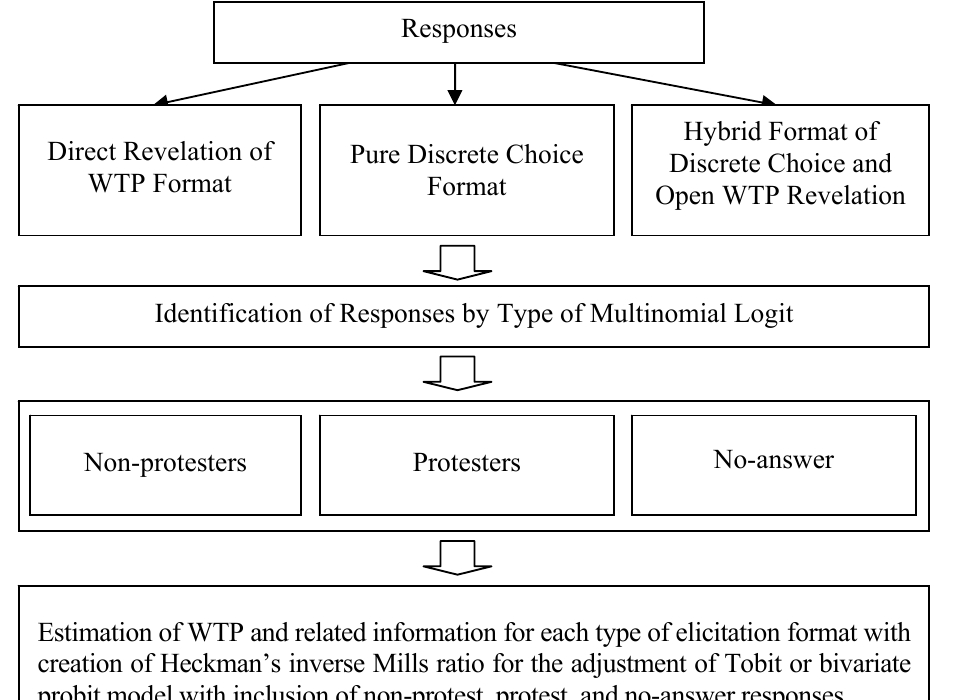
Fig. 1. The general model for non-protest, protest, and no-answer